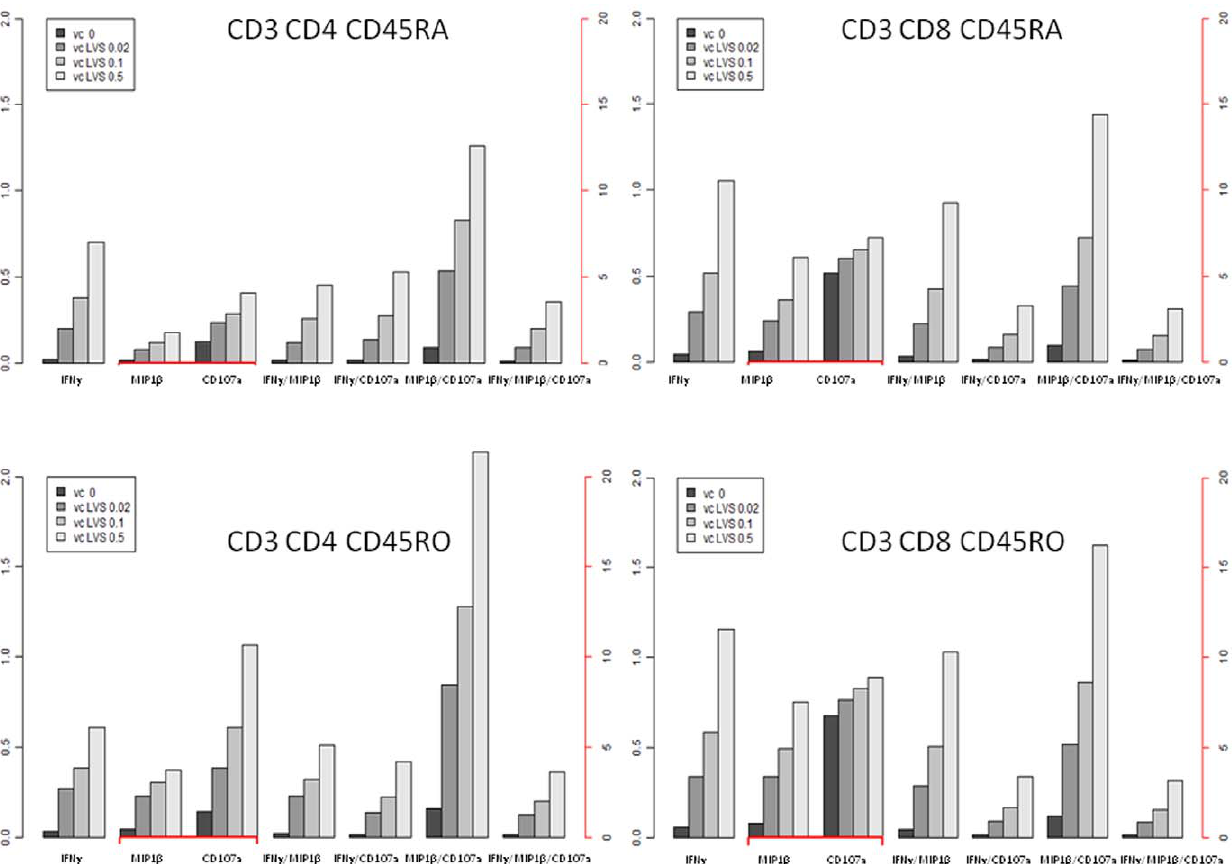
Figure 5. Histograms indicating the frequency of mono-, bi- and tri-functional cell subsets in CD45RO + and CD45RA + T-cell populations of vaccinees. Mean values are illustrated throughout. The black axis indicates percentages for mono-functional IFN- c -positive and all bi- and tri-functional T-cell subsets. The red axis indicates percentages for MIP-1 b - and CD107a-positive mono-functional T cell subsets.